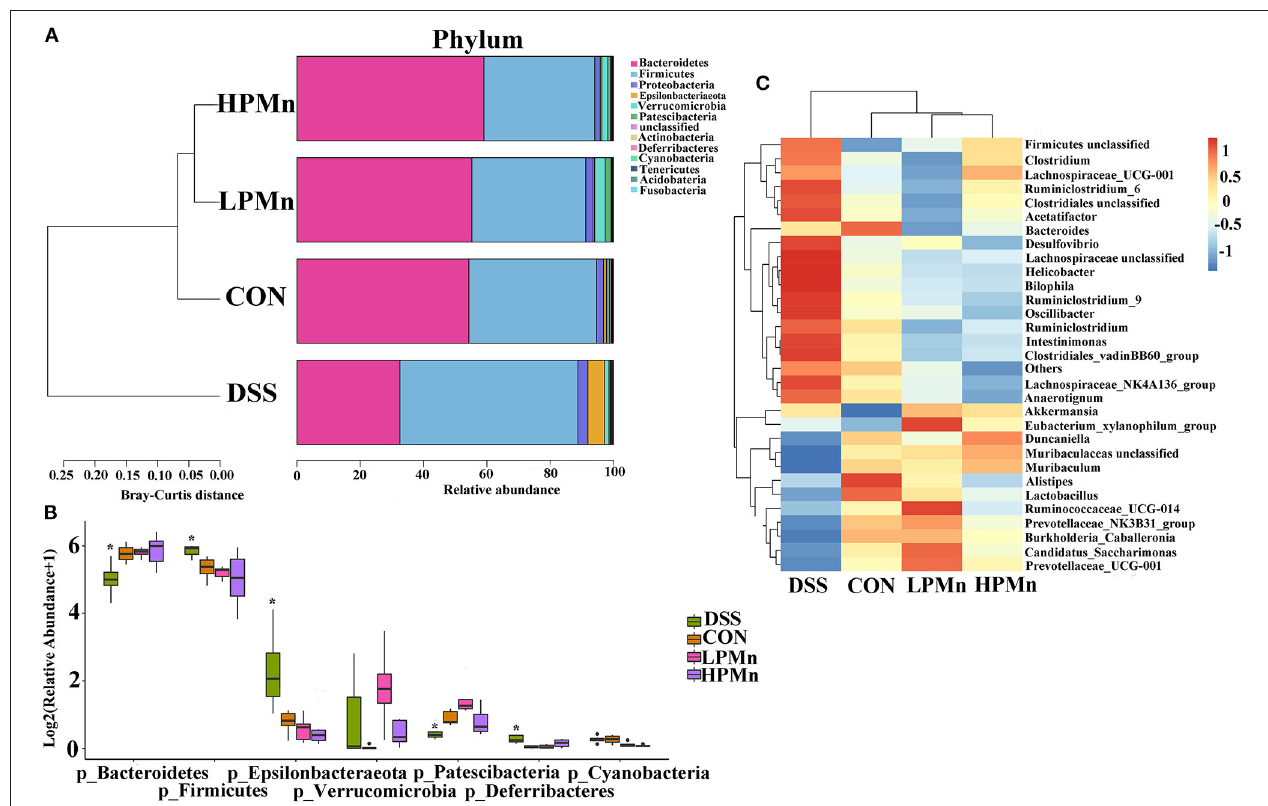
FIGURE 5 | Ulva polysaccharide-manganese altered microbial composition. (A,B) Relative abundance of predominant bacteria at the phylum level. (C) Relative abundance of predominant bacteria at the genus level. Values are expressed as mean ± SEM, n = 7. * P < 0.05 (Significant difference between DSS group and other three